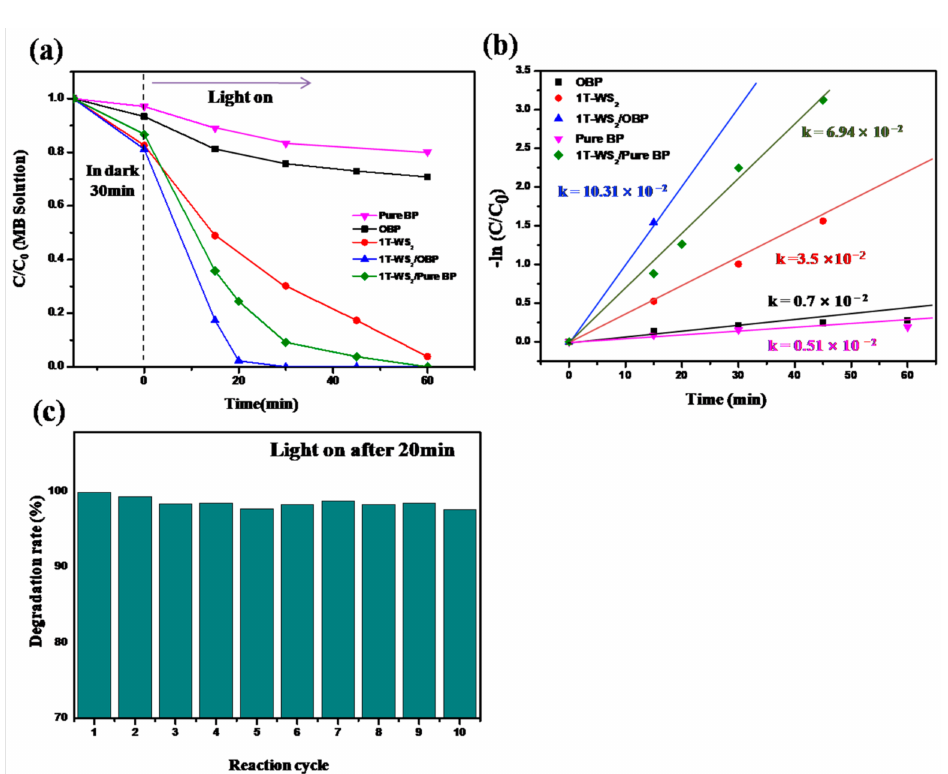
Figure 7. ( a ) Photocatalytic degradation of methylene blue solution and ( b ) pseudo-first-order kinetics over the various samples. ( c ) Recycling test for the photocatalytic degradation of methylene